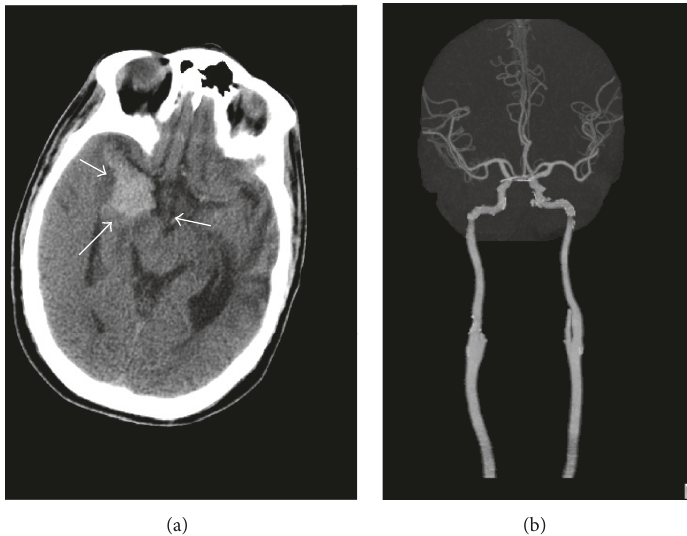
Figure3:(Day12)(a)noncontrastCTofthebraindemonstratesintervaldevelopmentofacutehemorrhagewithinmedialrighttemporallobe, a rare complication of herpes simplex encephalitis. (b) CT angiogram with IV contrast: coronal MIP reconstruction demonstrates patency of the intracranial circulation, with widely patent intracranial arteries, including middle cerebral arteries. Arrows in (a) refer to area of acute hemorrhage within the right medial temporal